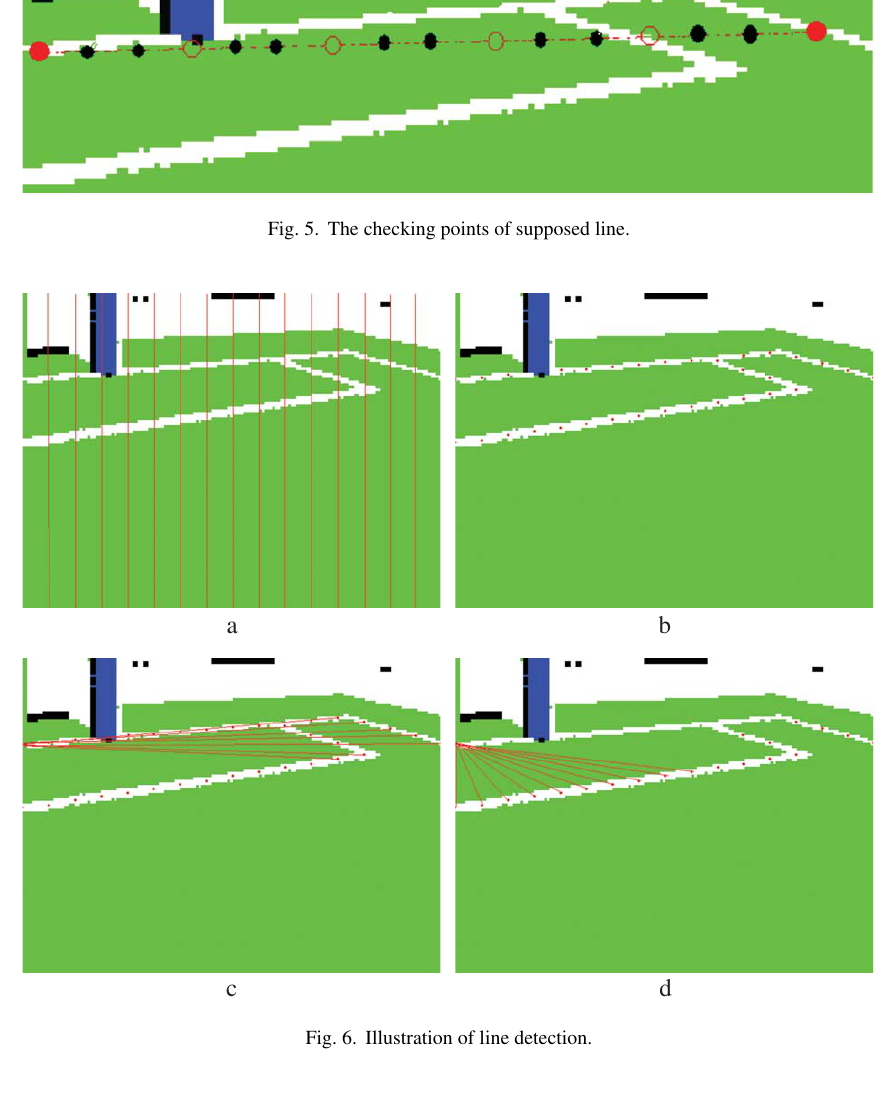
Fig. 6. Illustration of line